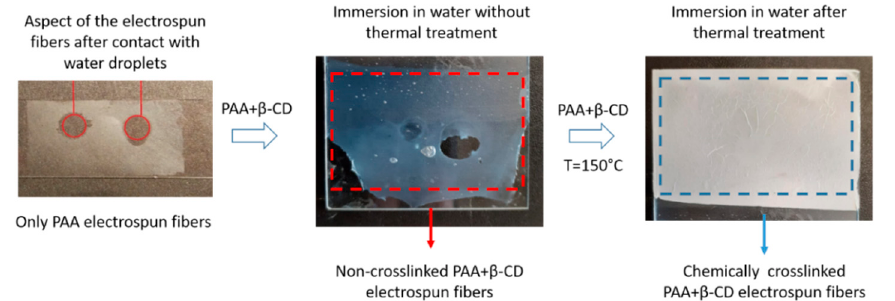
Figure 3. Aspect of the electrospun fiber coatings after immersion in water for PAA only, PAA + β - CD without thermal treatment and thermally treated PAA + β -CD electrospun fiber mats with the corresponding change in the coloration induced by the chemical crosslink.